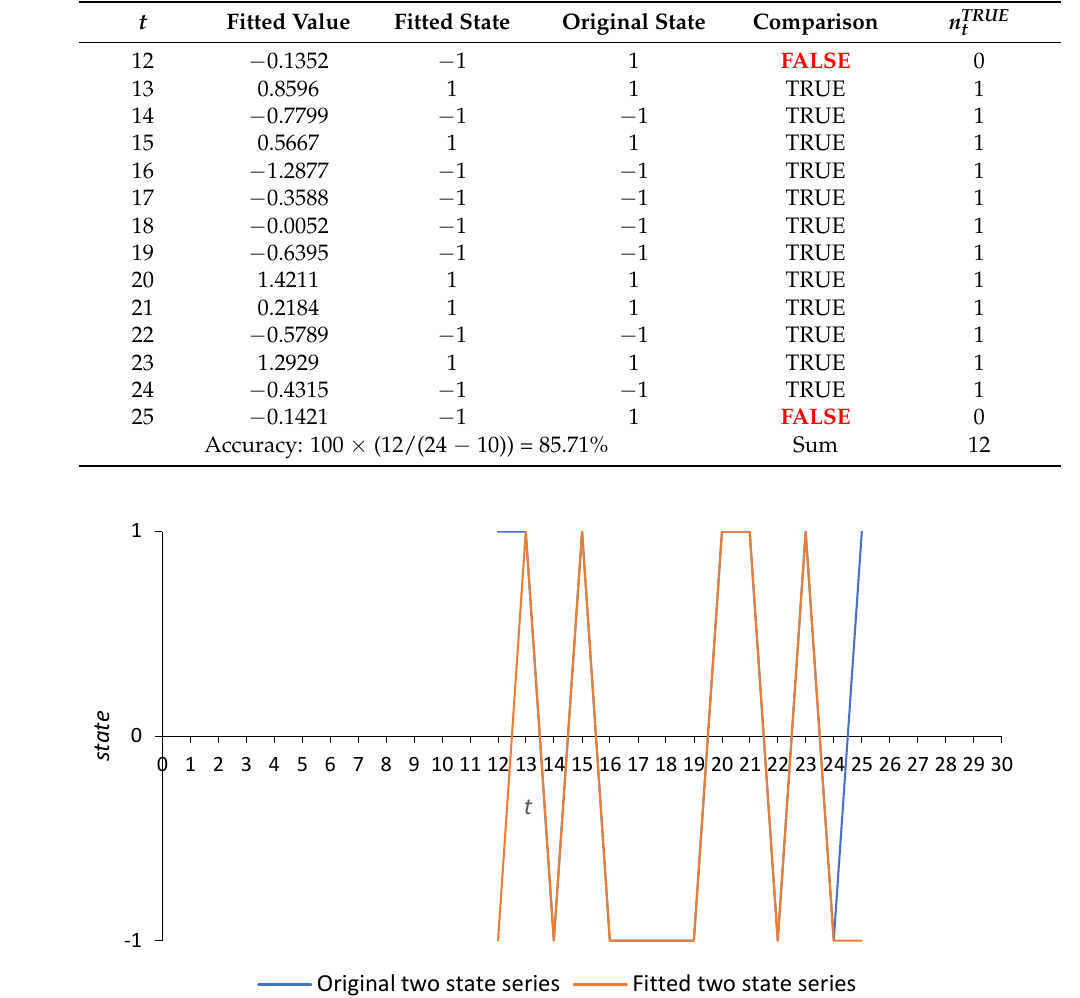
Table 20. Fitted series with corresponding states, and model accuracy for M4 x –the first difference.